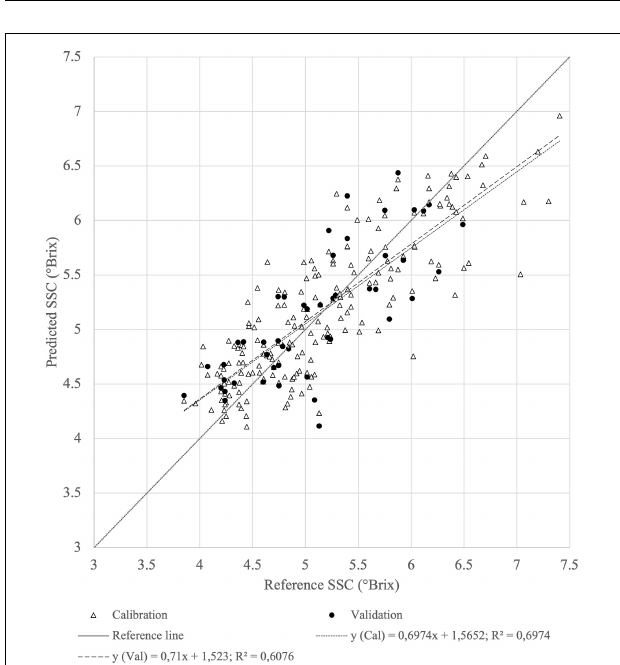
FIGURE 7 | Calibration (Cal) and validation (Val) set of reference ( n = 99) vs. predicted ( n = 33) SSC of tomato homogenates derived from the best PLSR model from reflectance of SWIR spectra with first derivative preprocessing.